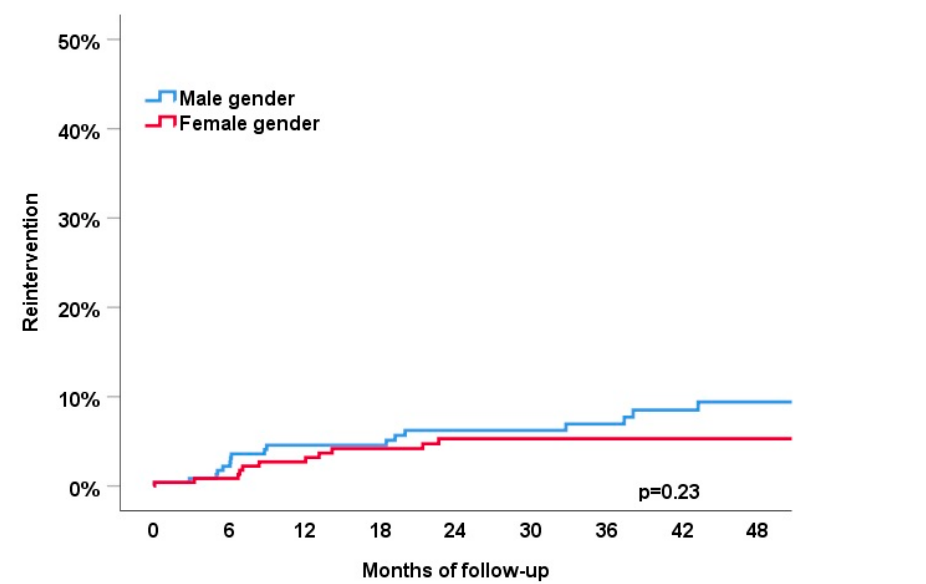
Figure 3. Association of sex category with the device-related reinterventions (lead failure, infections or upgrade to ICD or CRT) during 4 years of follow-up.